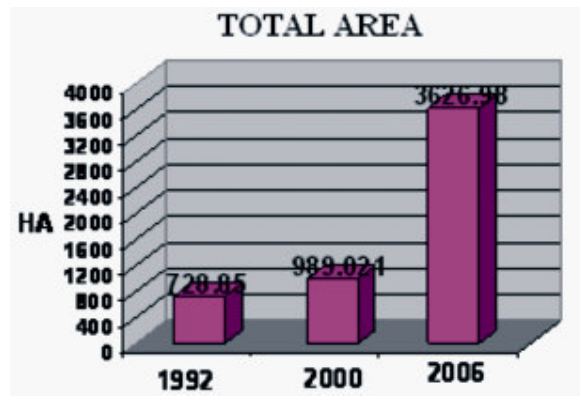
FIGURE 8. Three-dimensional temporal urban area change graphics for Küçükçekmece Water